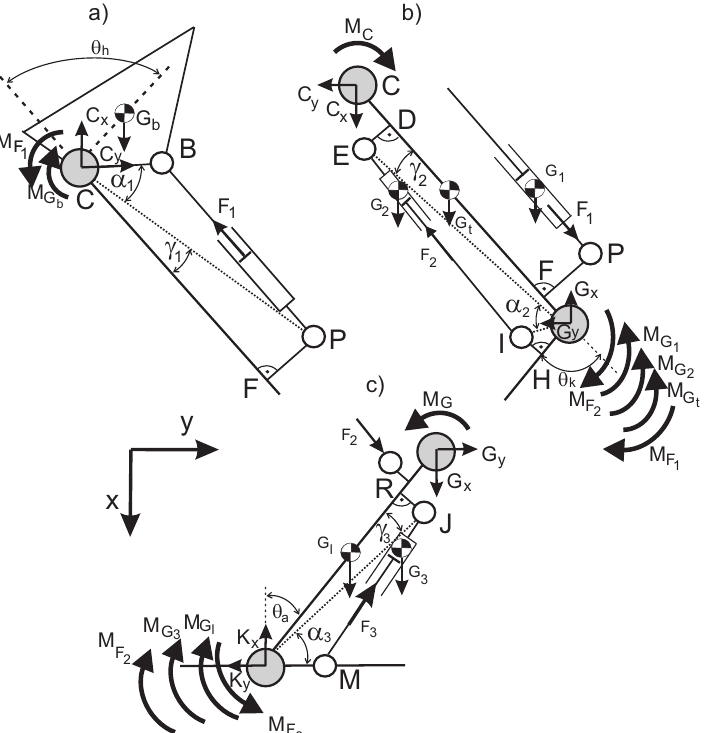
Figure 6. Diagrams of free limbs of the exoskeleton and lower limb with forces, moments of inertia, and reactive forces: ( a ) hip ( b ) knee ( c )